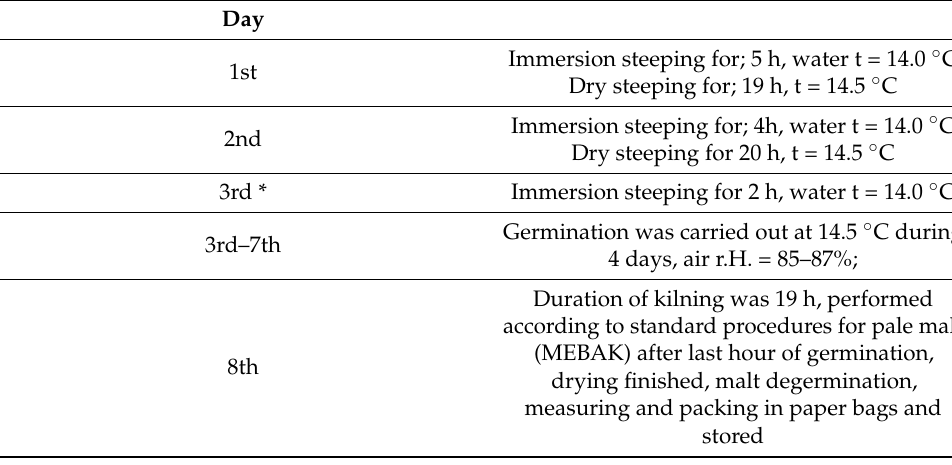
Table 1. Micromalting scheme of wheat samples.